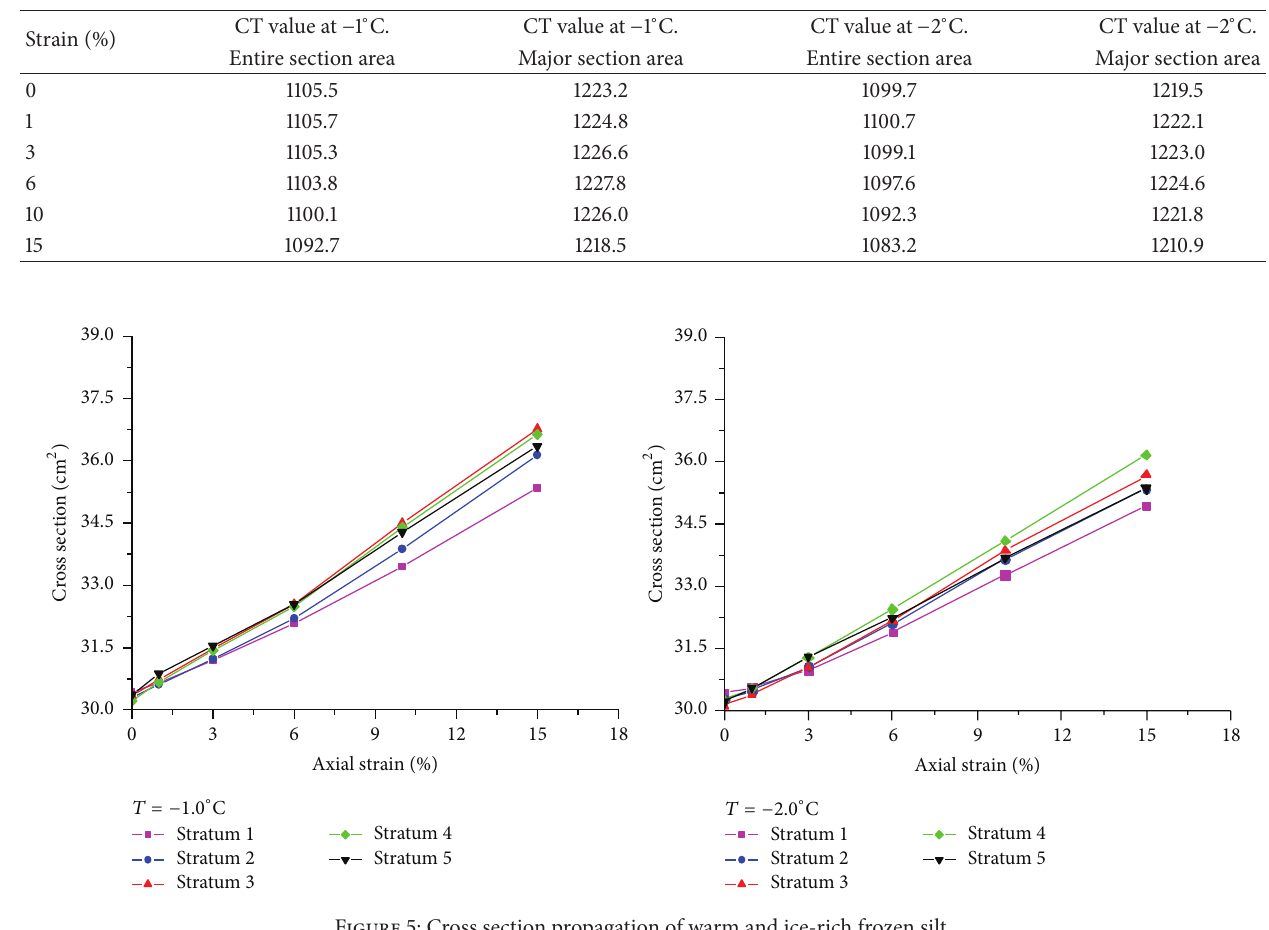
Table 1: Distribution regularities of CT values of scanned slices.